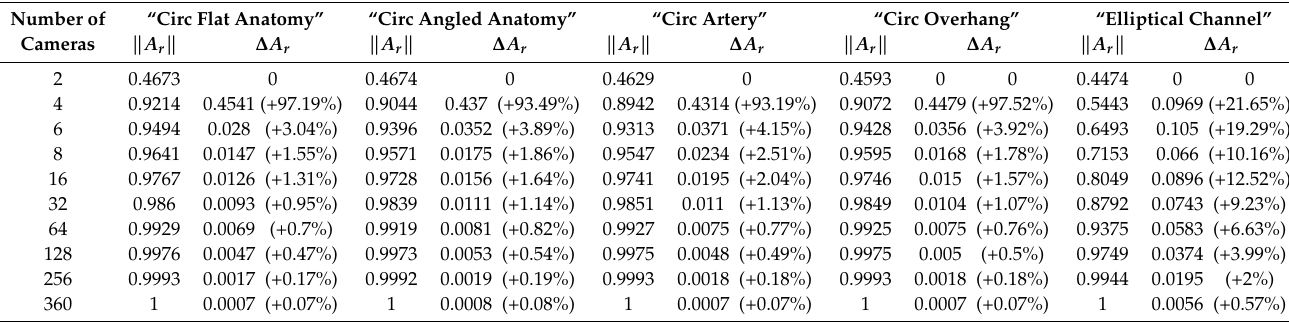
Table 3. Reconstructable areas ( A r ) of the 100mm channel models for different numbers of cameras, including the top surface. The area values for each mesh are normalized to the area of the respective mesh which is reconstructable with 360 cameras. ∆ A r denotes the increase in reconstructable area from the next smaller number of